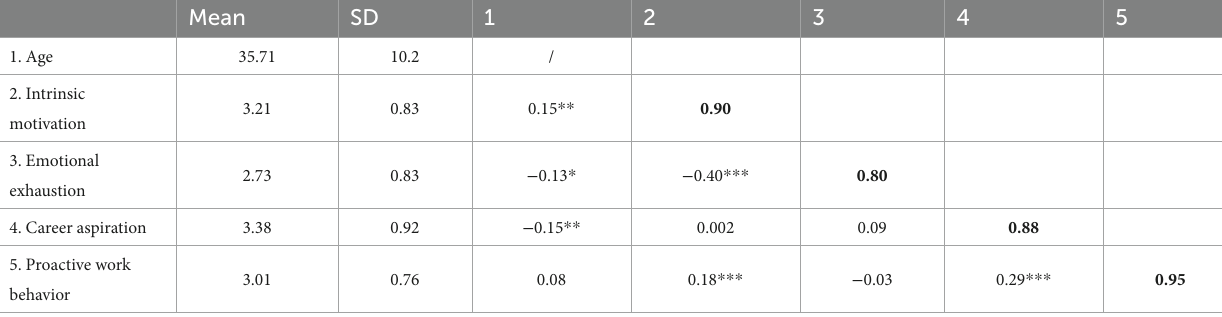
TABLE 2 Descriptive statistics, reliability coefficients, and